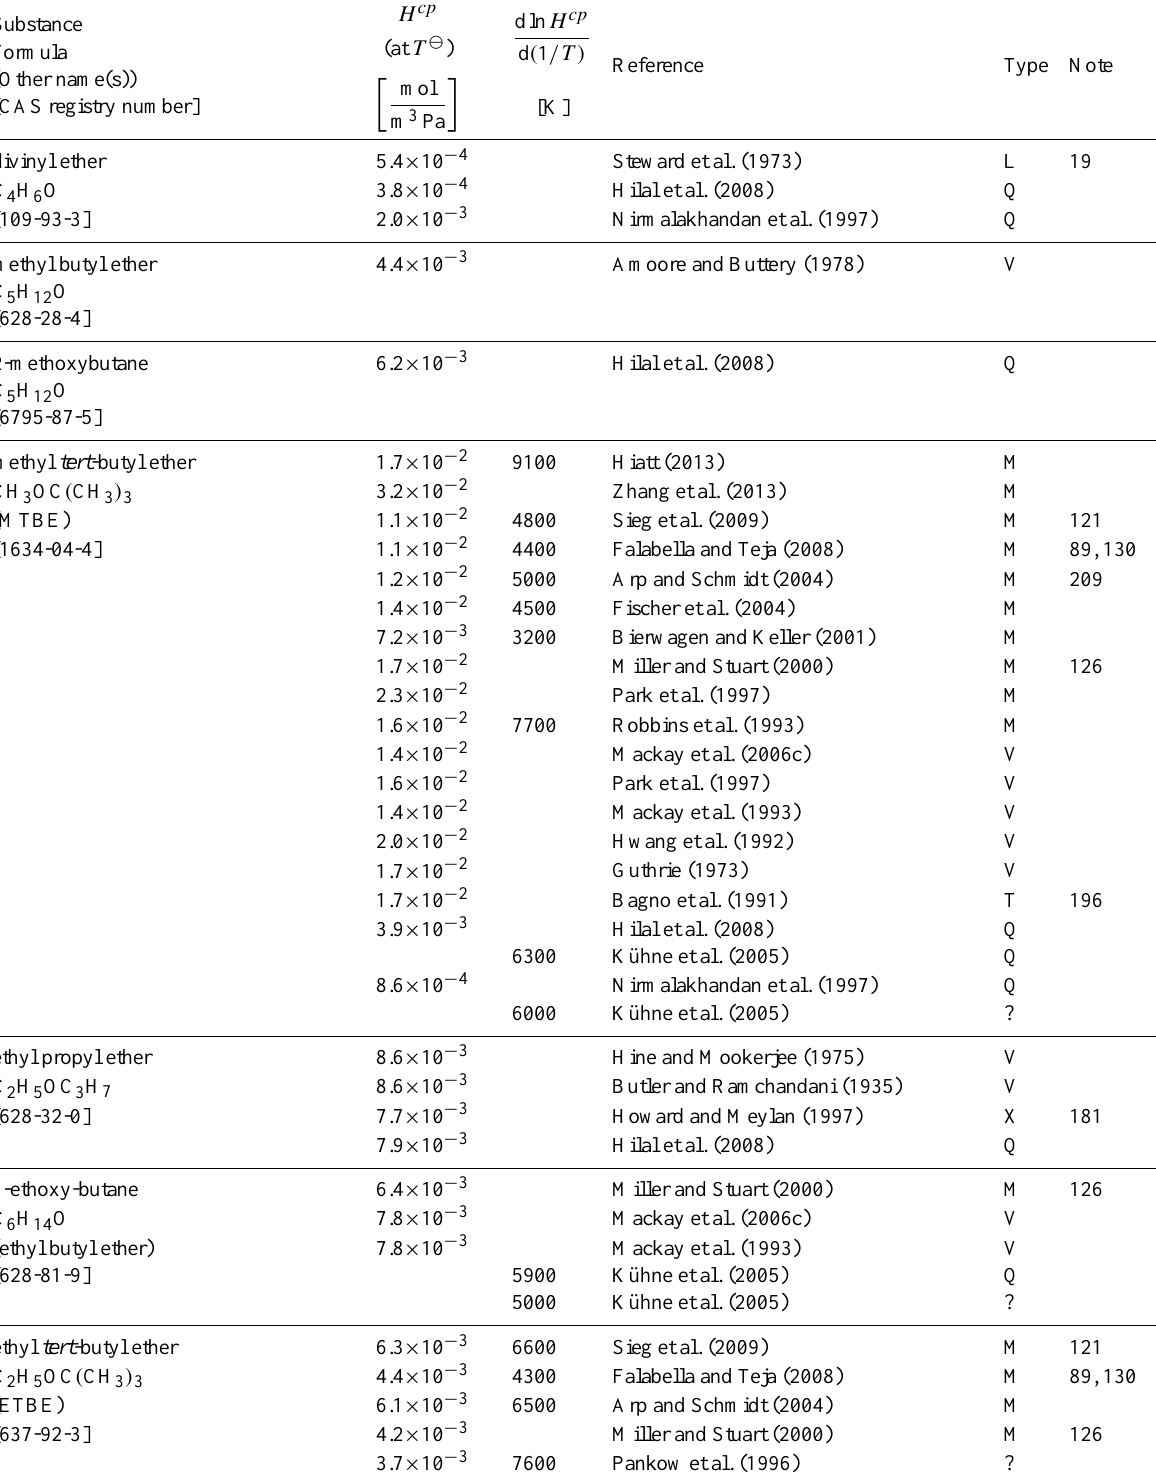
Table 6: Henry’s law constants for water as solvent